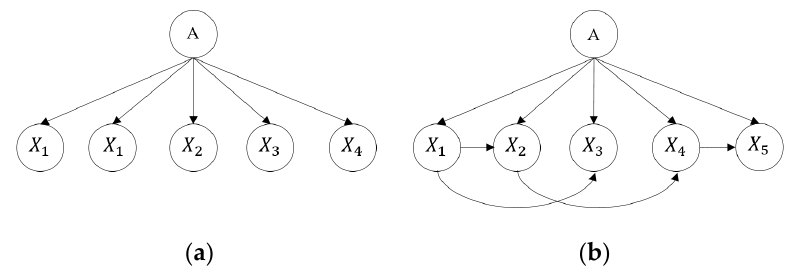
Figure 3. Typical structures of ( a ) NBN and ( b ) TAN.